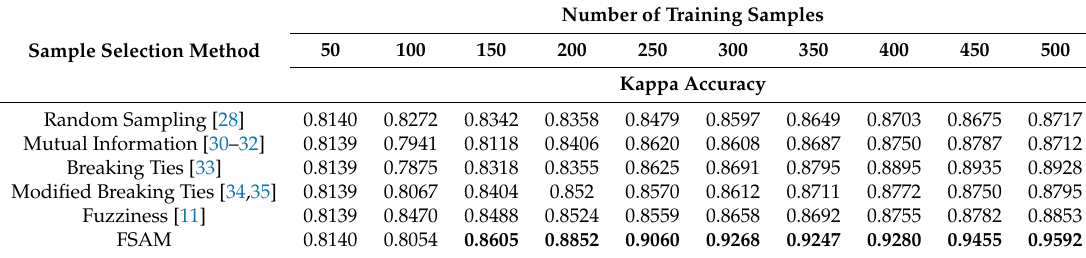
Table 7. Kappa ( κ ) accuracy obtained by GB Classifier with different number of training samples selected in each iteration from Botswana dataset with different sample selection methods from literature.